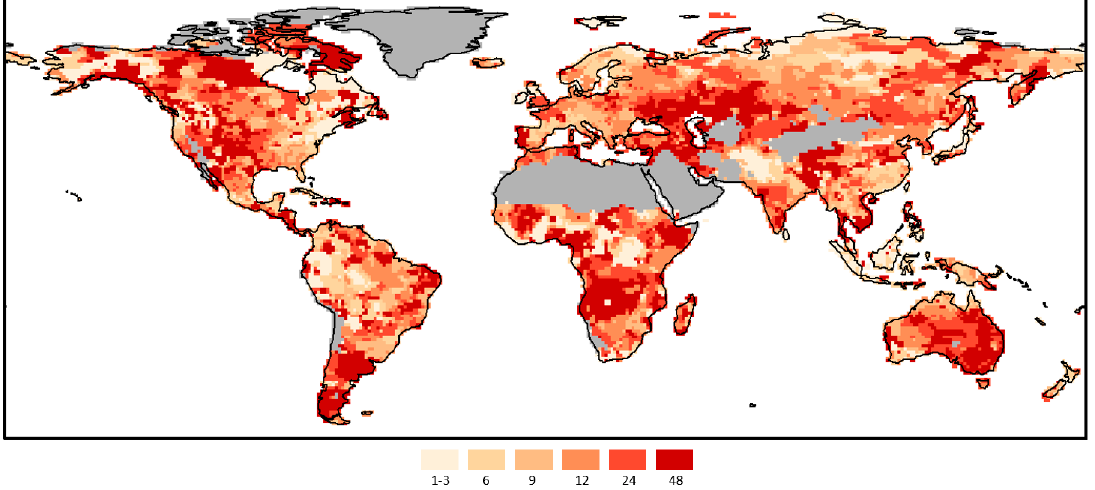
Figure 4. Spatial distribution of the SPI accumulation period returning the maximum R between SPI and TWSA. Masked cells (where liquid rainfall was < 100 mm annum) are represented in grey.